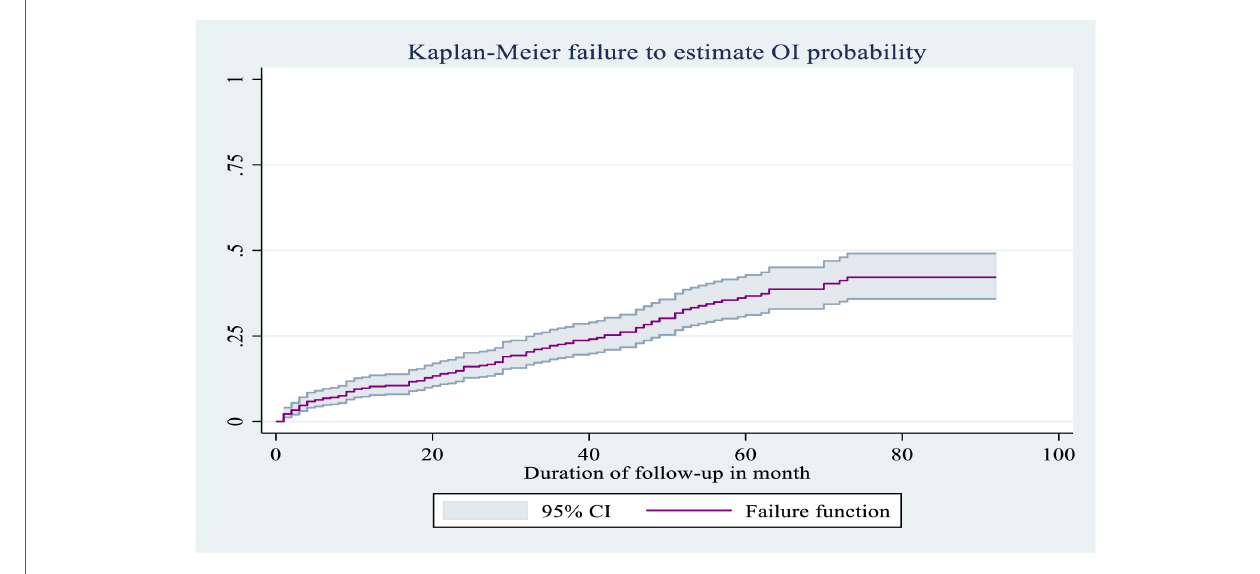
FIGURE 4 Overall Kaplan – Meier failure as an estimate of the probability of occurrence of OI (with 95% con fi dence interval) among HIV-infected children receiving ART at Amhara regional state comprehensive specialized hospitals, Ethiopia, 2022.